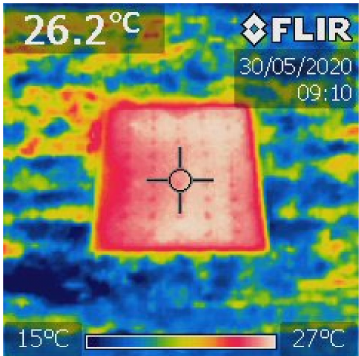
Figure 1. PV panel-thermographic image (source, prepared by the